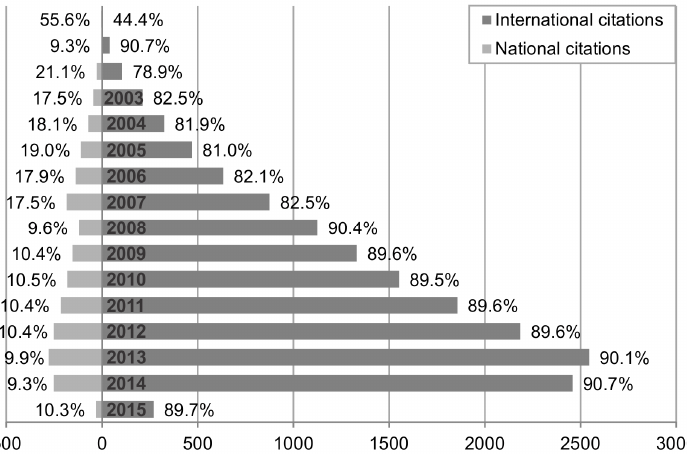
Figure 4. National versus international articles in Brazilian scientific output in Evolutionary Biology.